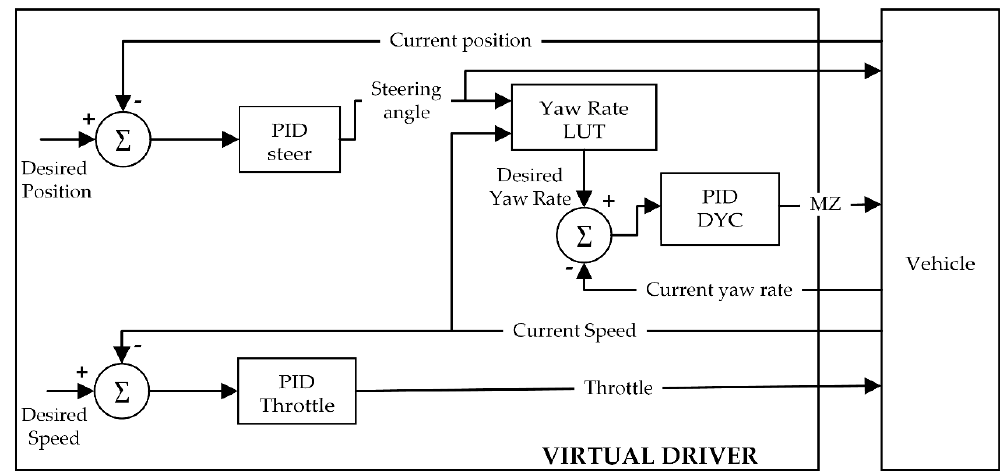
Figure 2. Nested PID controllers behind the virtual driver agent module. Three independent PID controllers are used to calculate the values of the steering wheel angle ( δ ), the throttle command (th), and, in the case of a vehicle with DYC, the desired yaw moment, Mz, input.